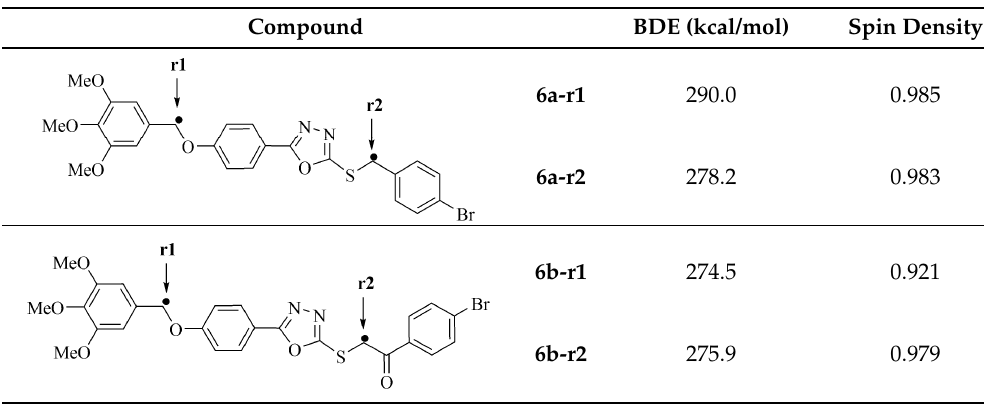
Table 3. Calculated properties for compounds 6a and 6b .